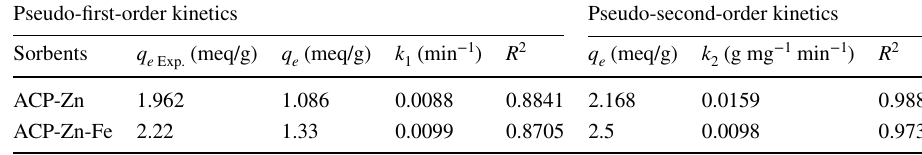
Table 4 Characteristics of kinetic models for Cr+6 ions removal using ACP-Zn and ACP-Zn-Fe